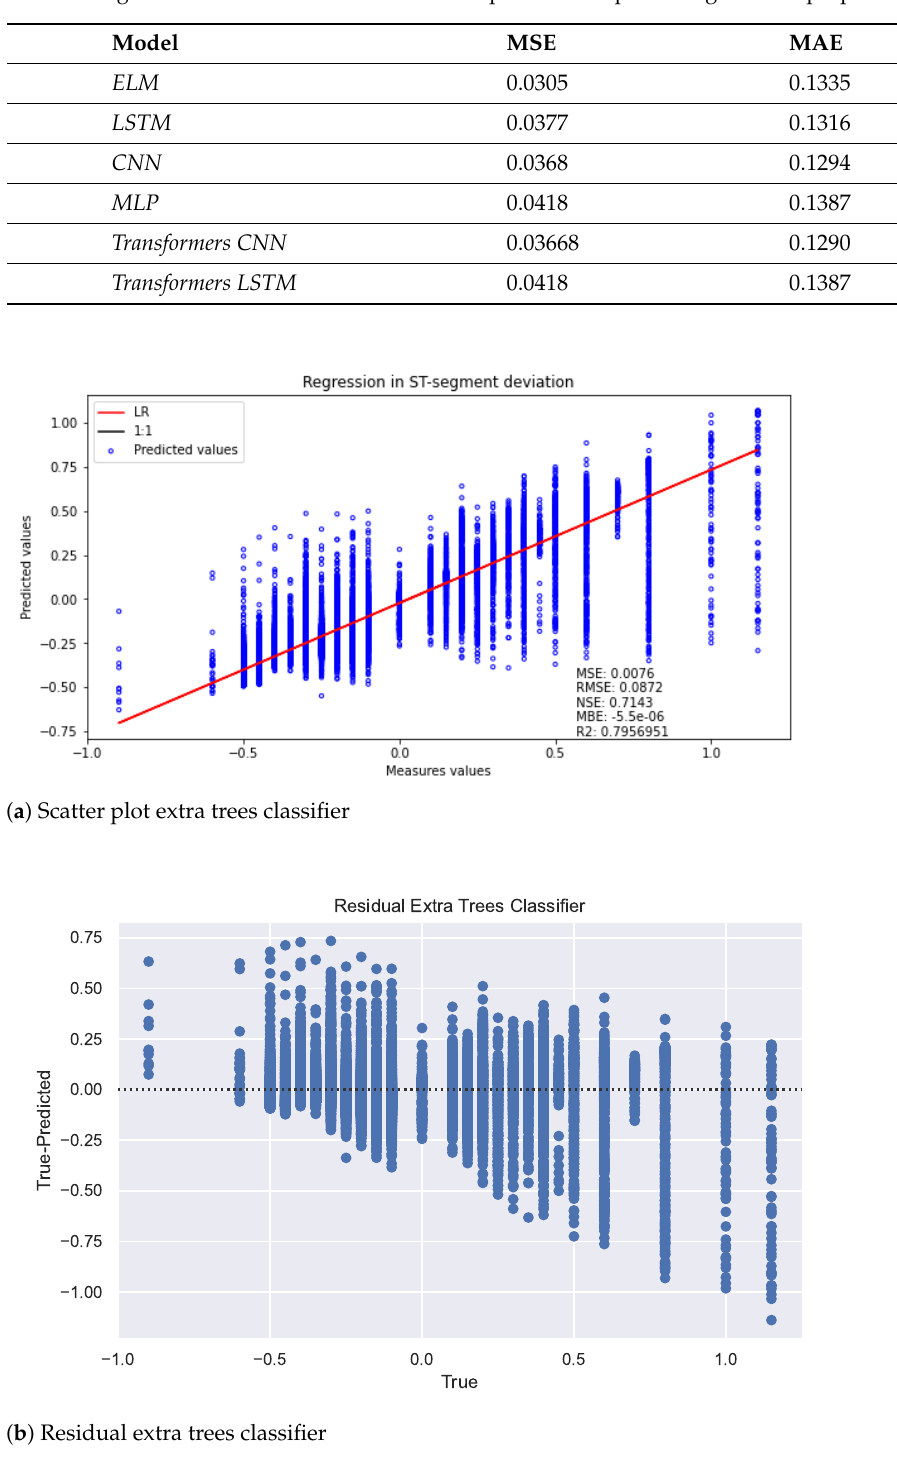
Figure 15. Result in the regression task used for this